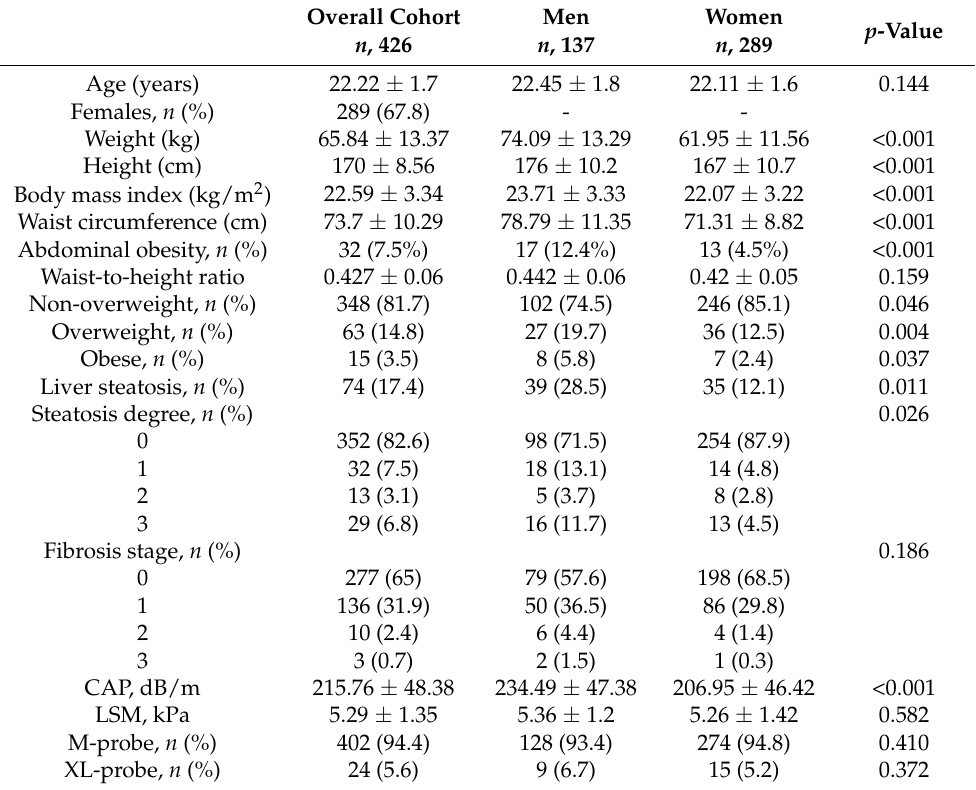
Table 1. The Characteristics of the overall participants included in the study according to gender.